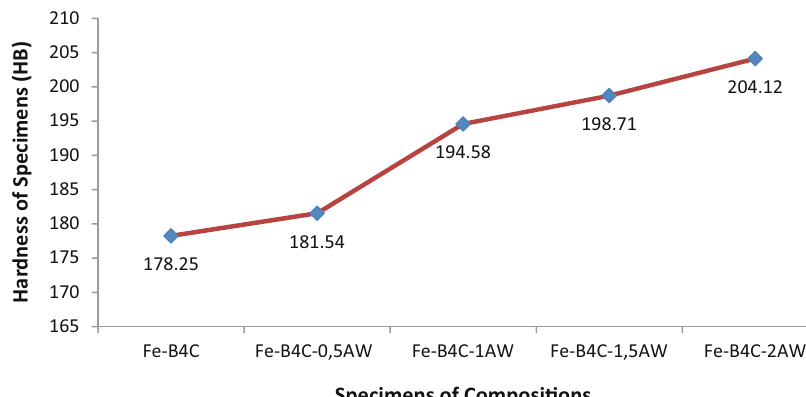
Figure 2: Composition – hardness change curve of ceramic – metal composite.